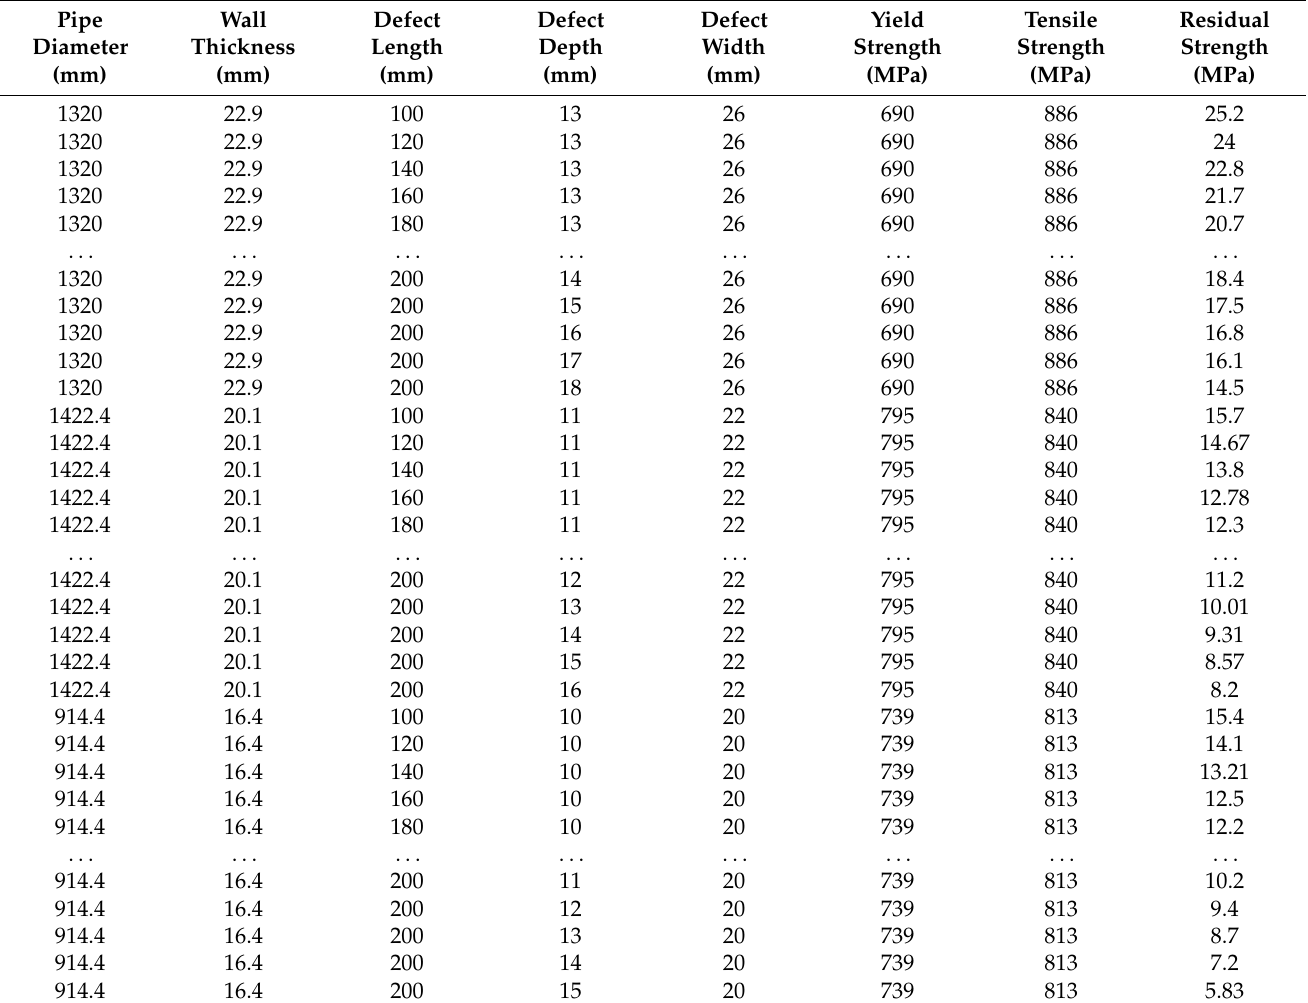
Table 7. Residual intensity sample